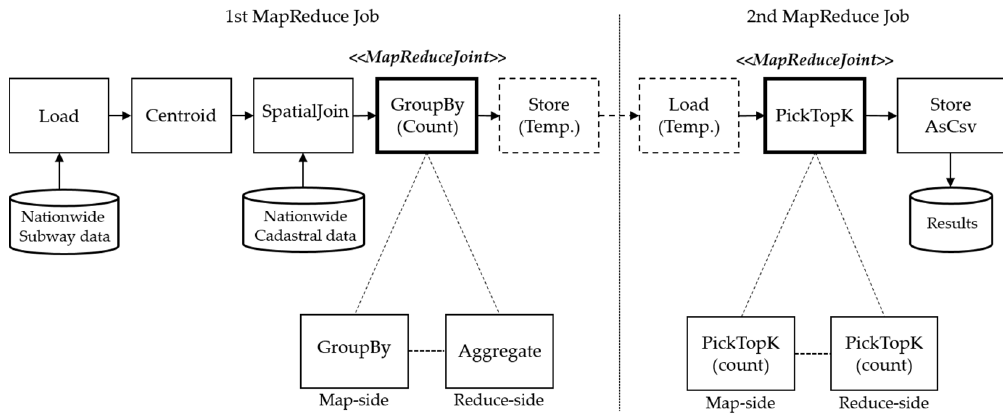
Figure 10. A sequence of RecordSetOperators consisting of the example Plan.